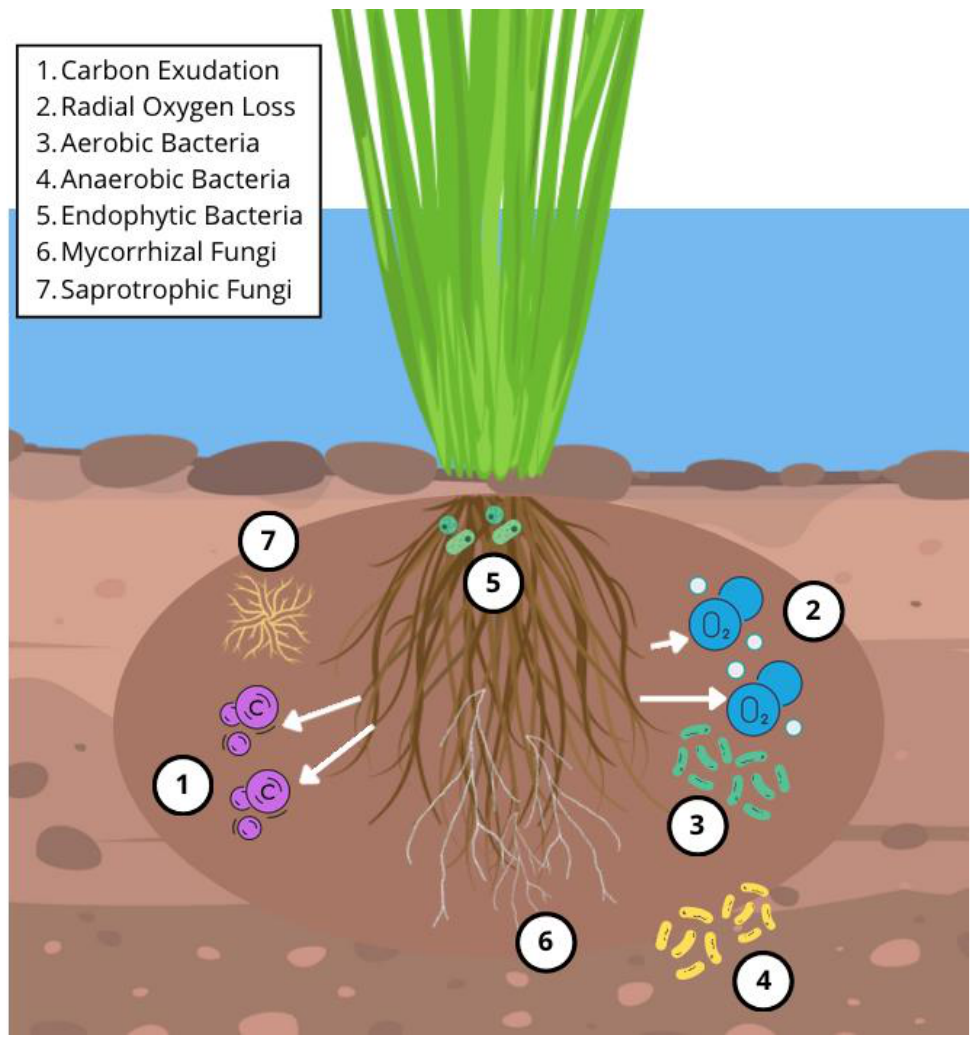
Figure 5. Rhizosphere processes and organisms related to rhizodegradation. The roots of emergent macrophytes perform the listed functions or facilitate the presence of listed organisms. Table 7. Types of organisms and functional roles for emerging contaminant removal in the rhizo- sphere.